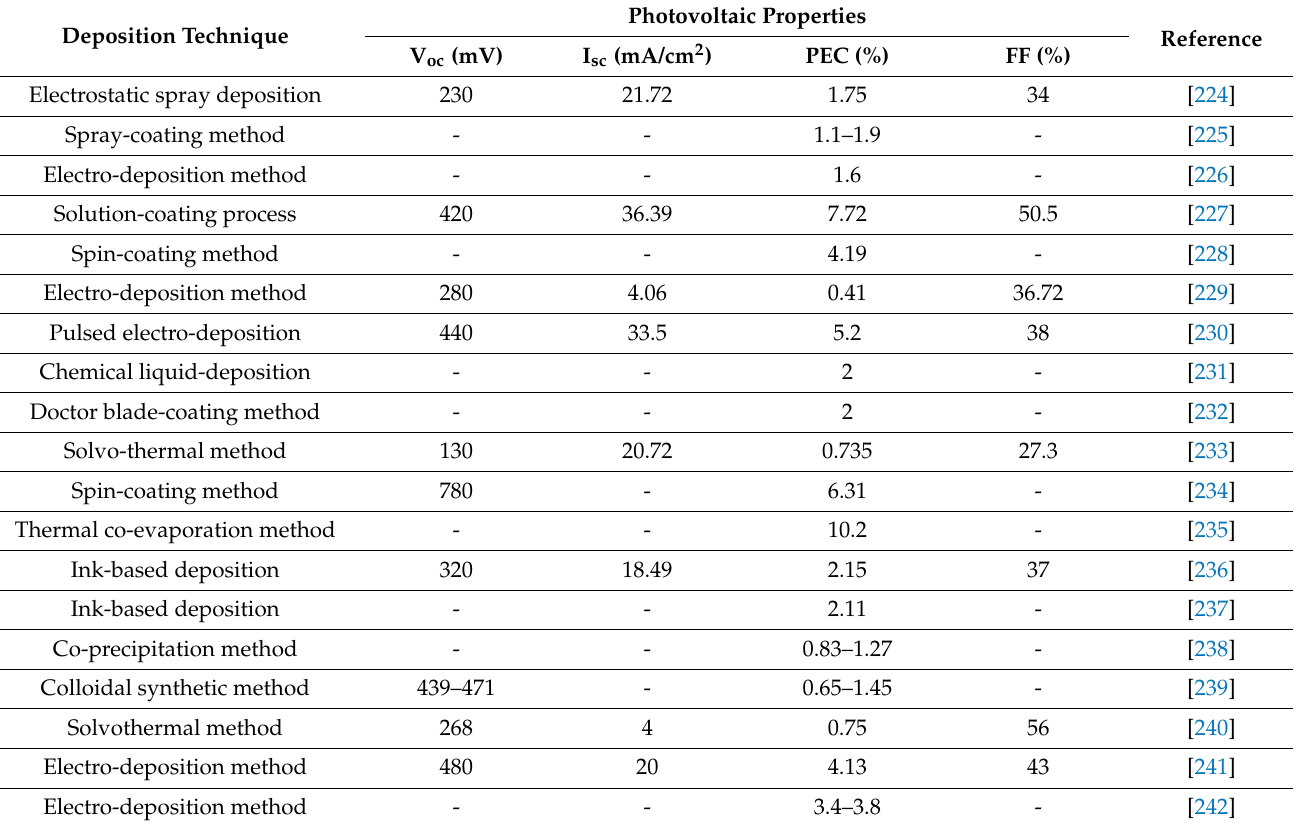
Table 5. The growth of CuInX (X = S, Se, and Te) films using various deposition methods and the photovoltaic properties.